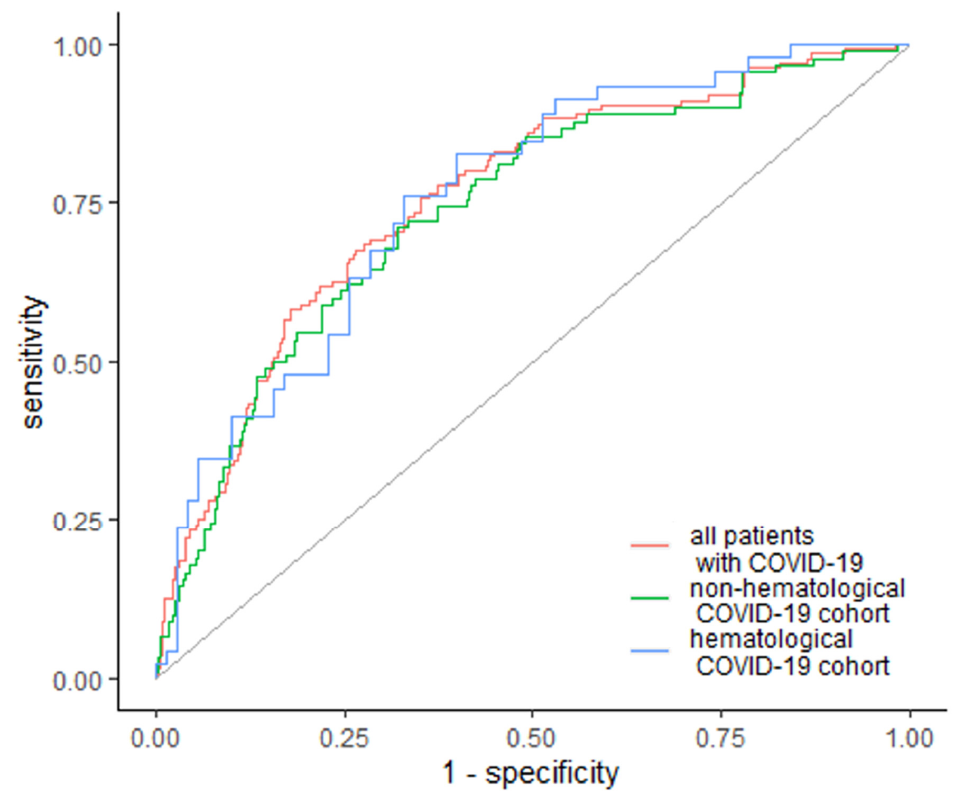
Figure 3. EASIX as a predictor of in-hospital mortality. Diagonal grey line represents random classifier (false positive rate = true positive rate).